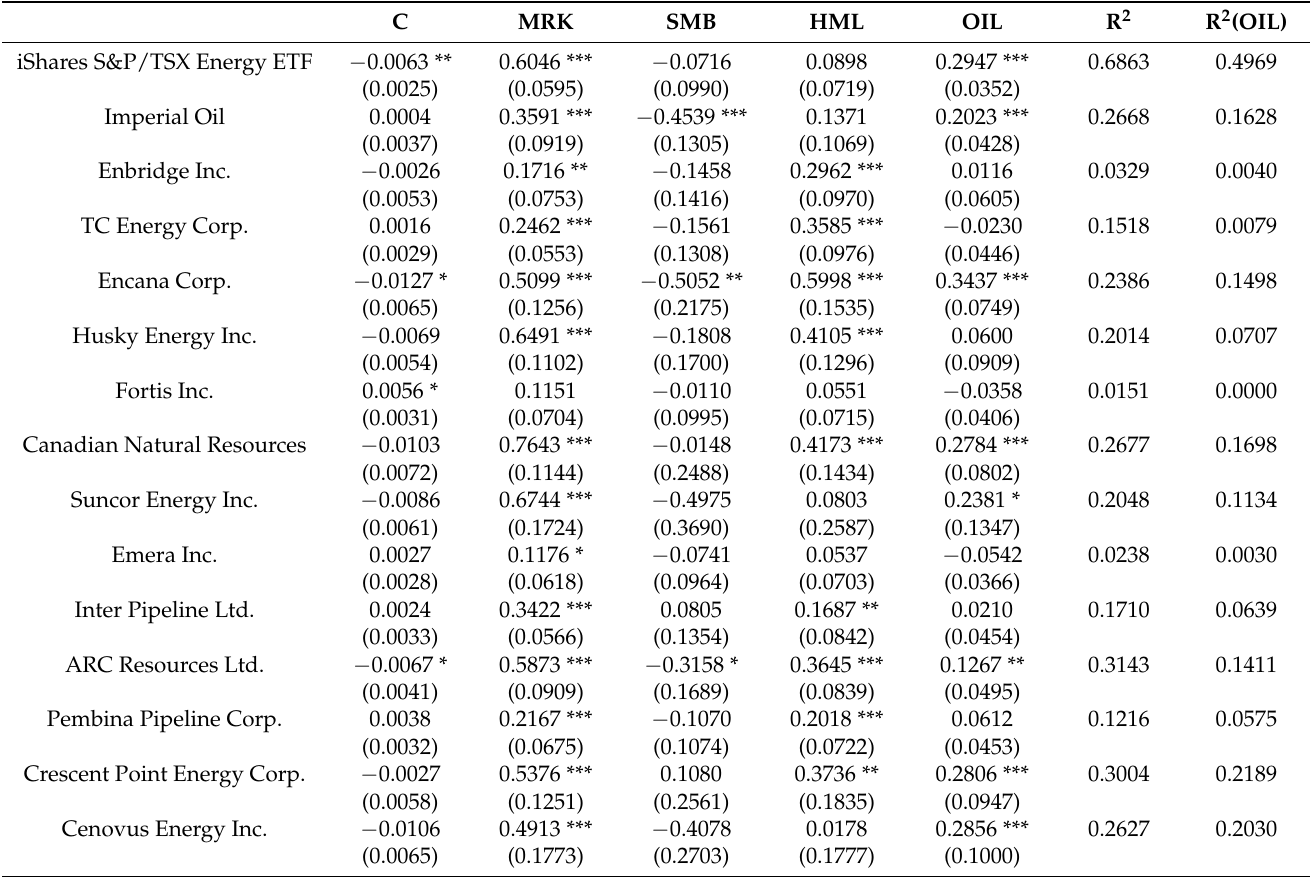
Table 2. Regression results—with